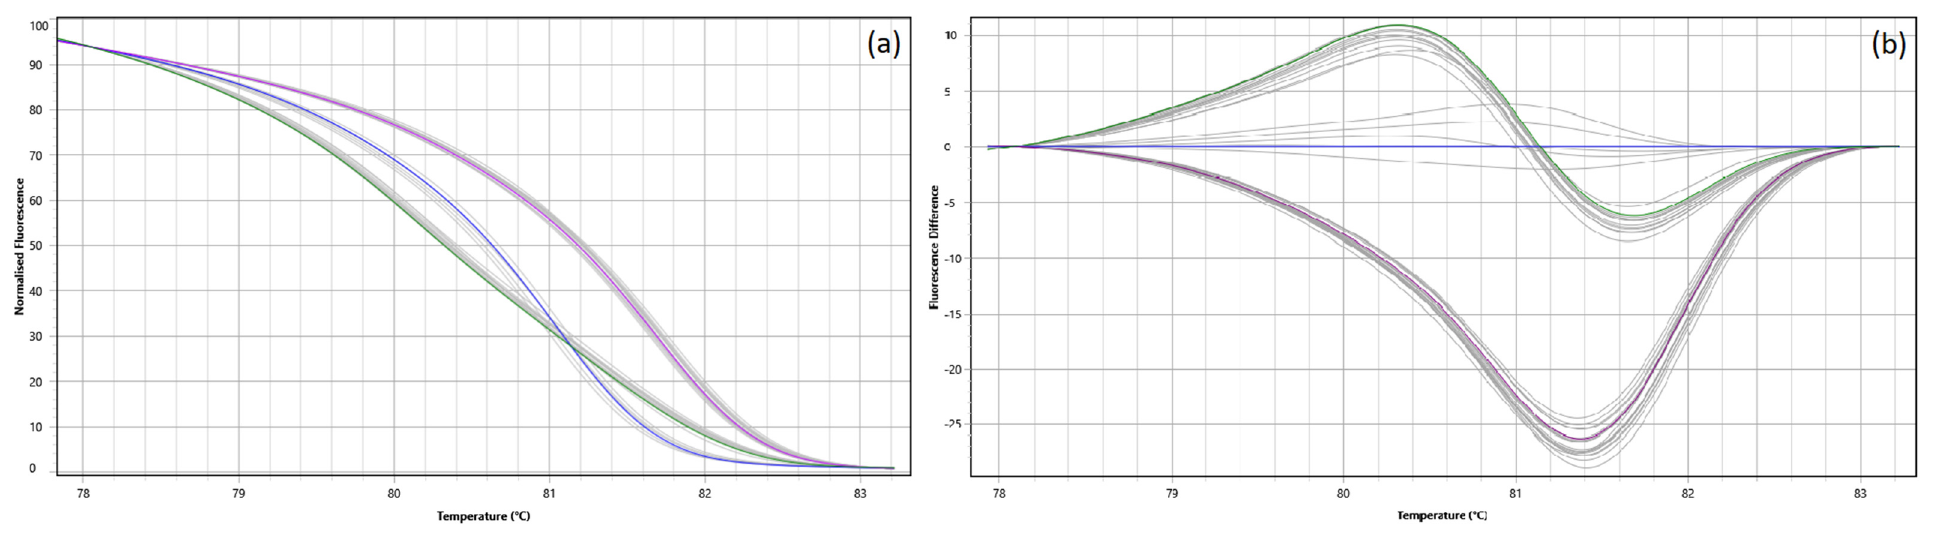
Figure 2. Example of PCR-HRM curves for the L7 SNP with alleles C/T. Each curve corresponds to one of the three possible genotypes. In purple ( — ) control curve C/C, in blue ( — ) control curve (T/T), in green ( — ) control curve (C/T) and in grey (—) query samples. ( a ) Normalized melting curves; ( b ) difference melting curves, using control curve for genotype T/T as reference.